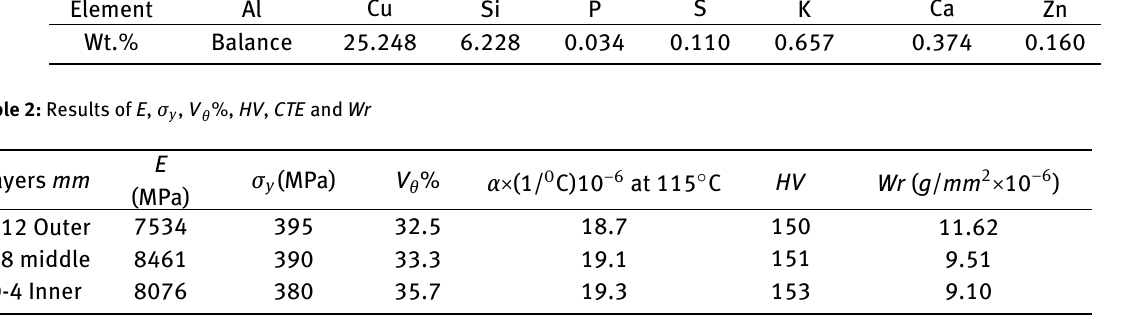
Table 1: Chemical composition of FGM ingot Element